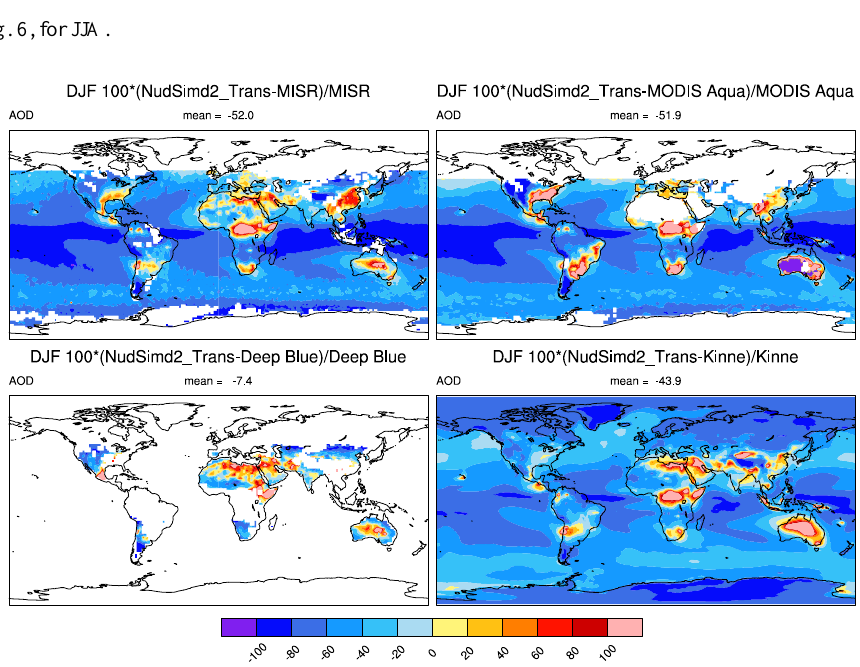
Figure 7. Same as Fig. 6, for JJA. Fig. 7. Same as Figure 6, for JJA.